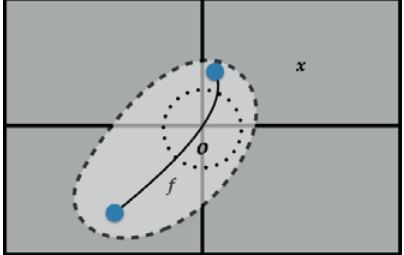
Figure 15: The visual argument for an edge-neighboring tile to tile x being non-empty when tile x has relation overlap with respect to object f